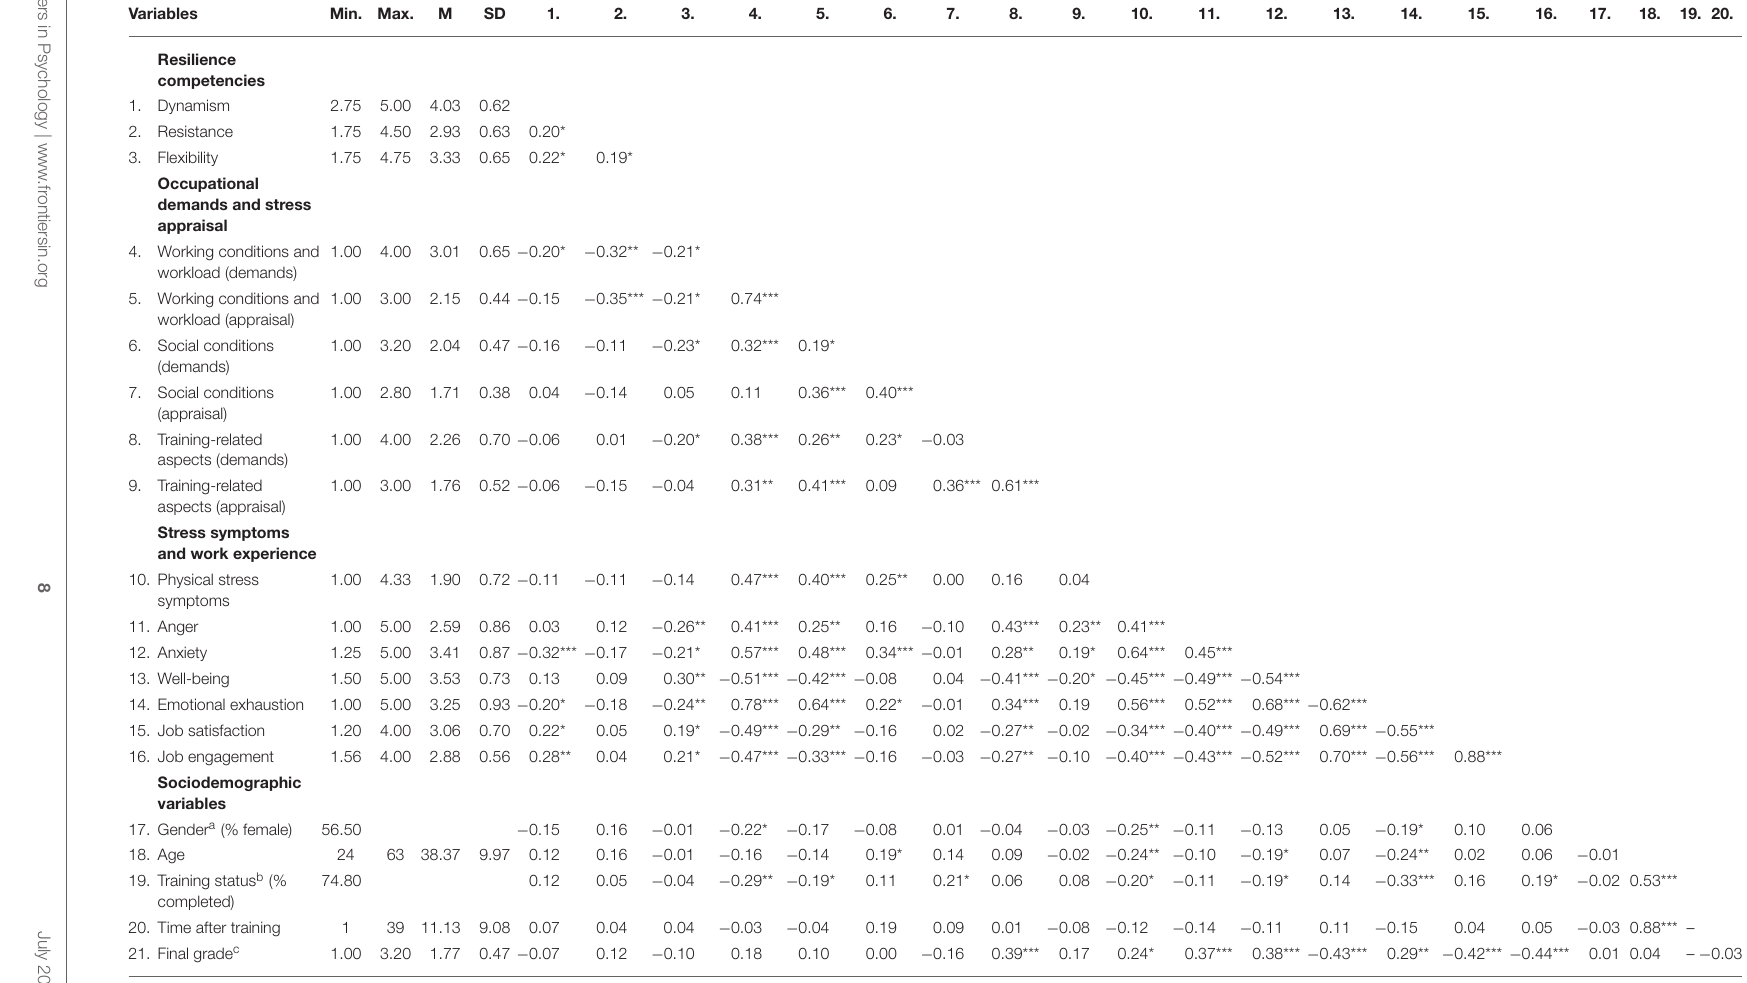
TABLE 2 | Descriptive data and Pearson